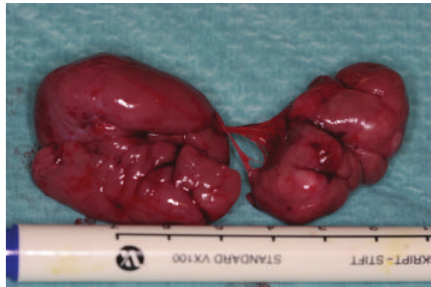
Figure 3: Right parapharyngeal ARM after